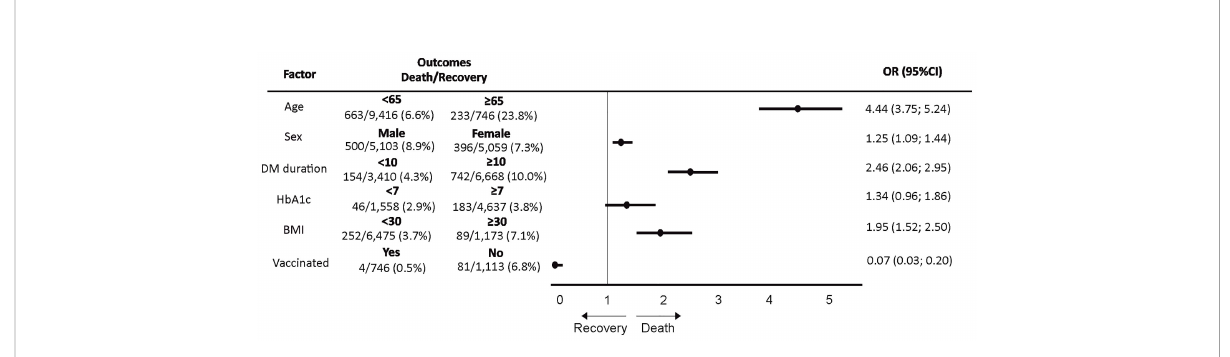
FIGURE 2 The analysis for association [odds ratio (OR)] between demographic and clinical characteristics and coronavirus disease 2019 (COVID-19) case fatality rate (recovery or death outcomes) in patients with type 1 diabetes mellitus